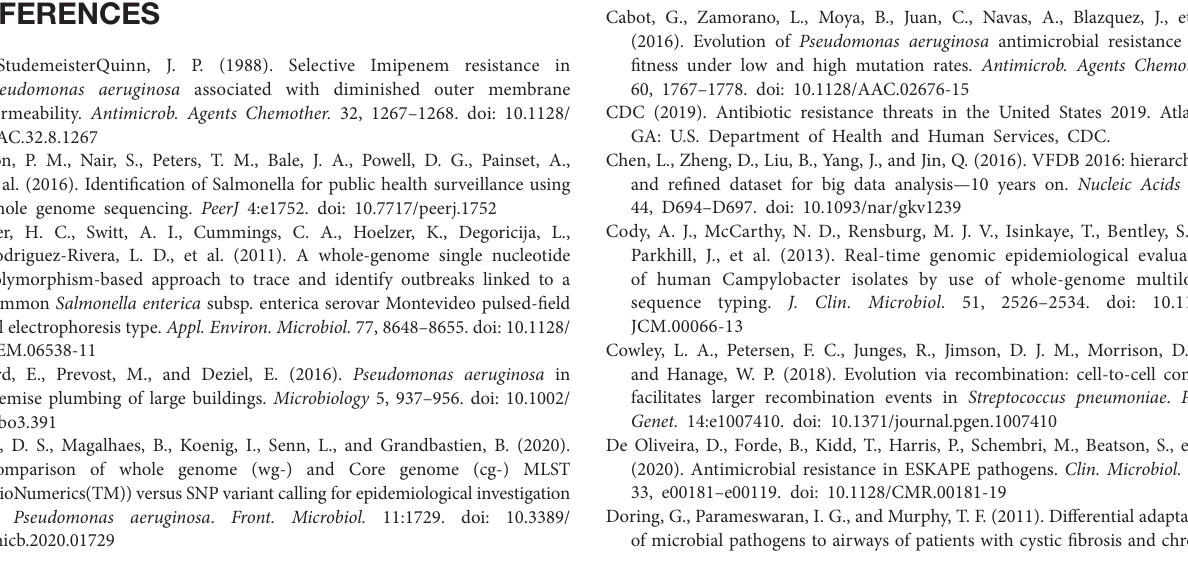
Frontiers in Microbiology | www.frontiersin.org